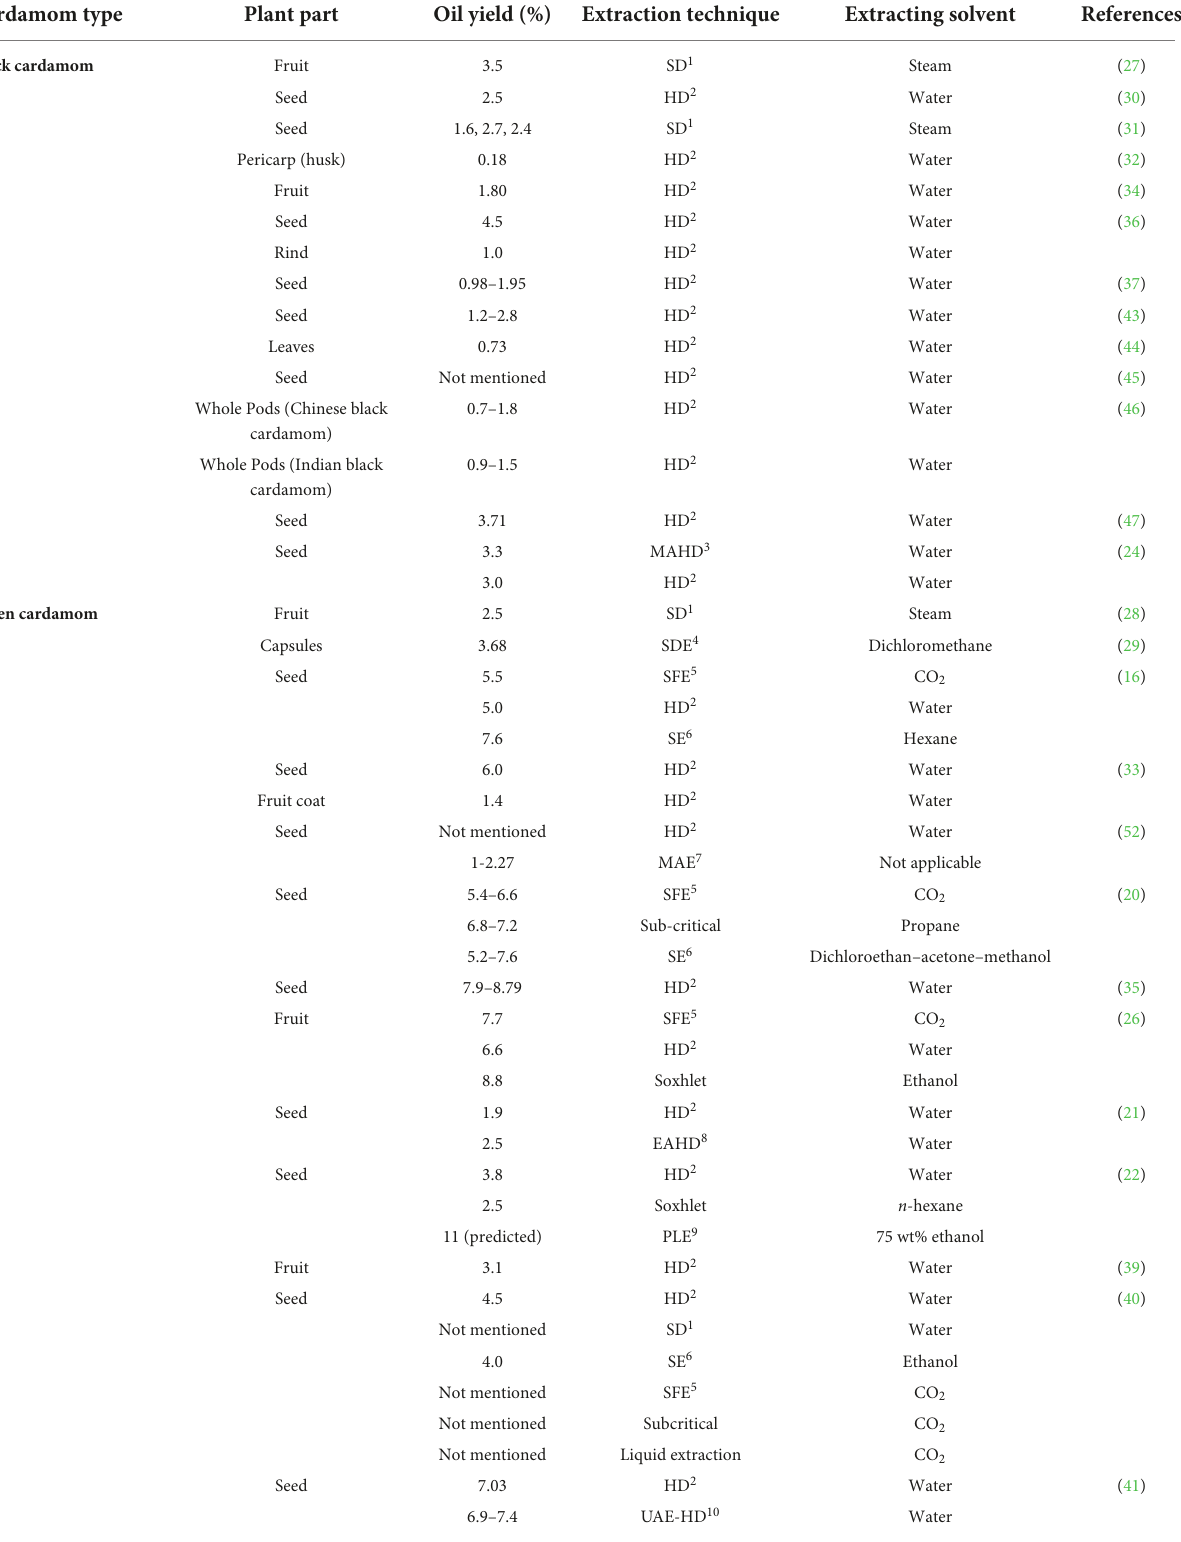
TABLE 2 Comparative analysis of black and green cardamom: plant part, oil yield (%), extraction method, and extraction solvent. Cardamom type Plant part Oil yield (%) Extraction